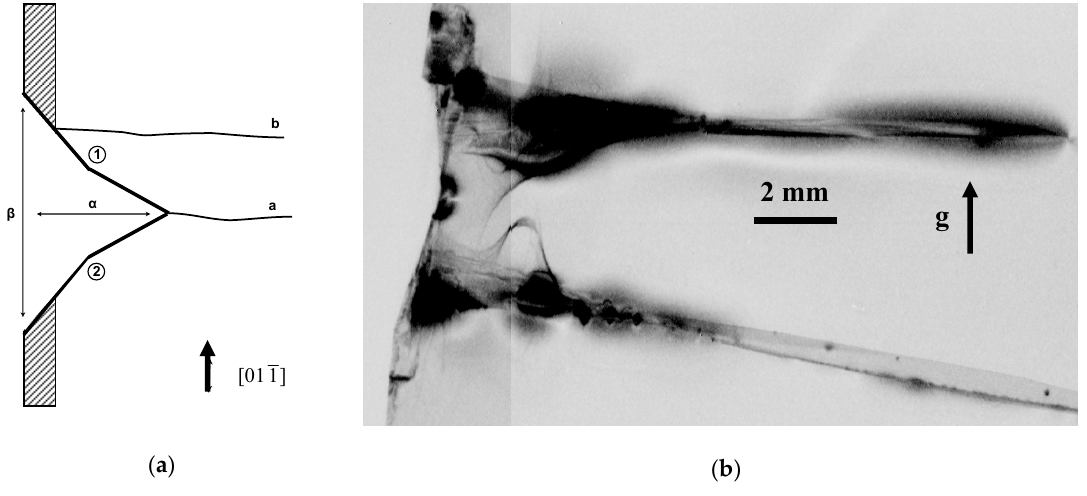
Figure 6. ( a ) Schematic diagram of the type 1 and type 2 macroscopic cracks generated by Vickers indentation within 75 μ m of the bevel edge. ( b ) Composite of white beam X-ray topographs of a pair of such cracks in 202 reflection. (The break-out dimensions α and β are not discussed here.)